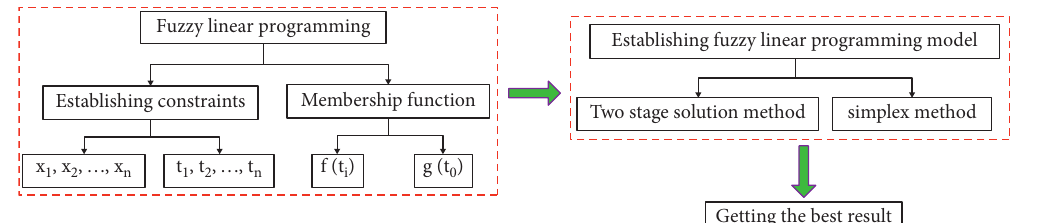
Figure 1: Specific flow diagram of solving fuzzy linear programming